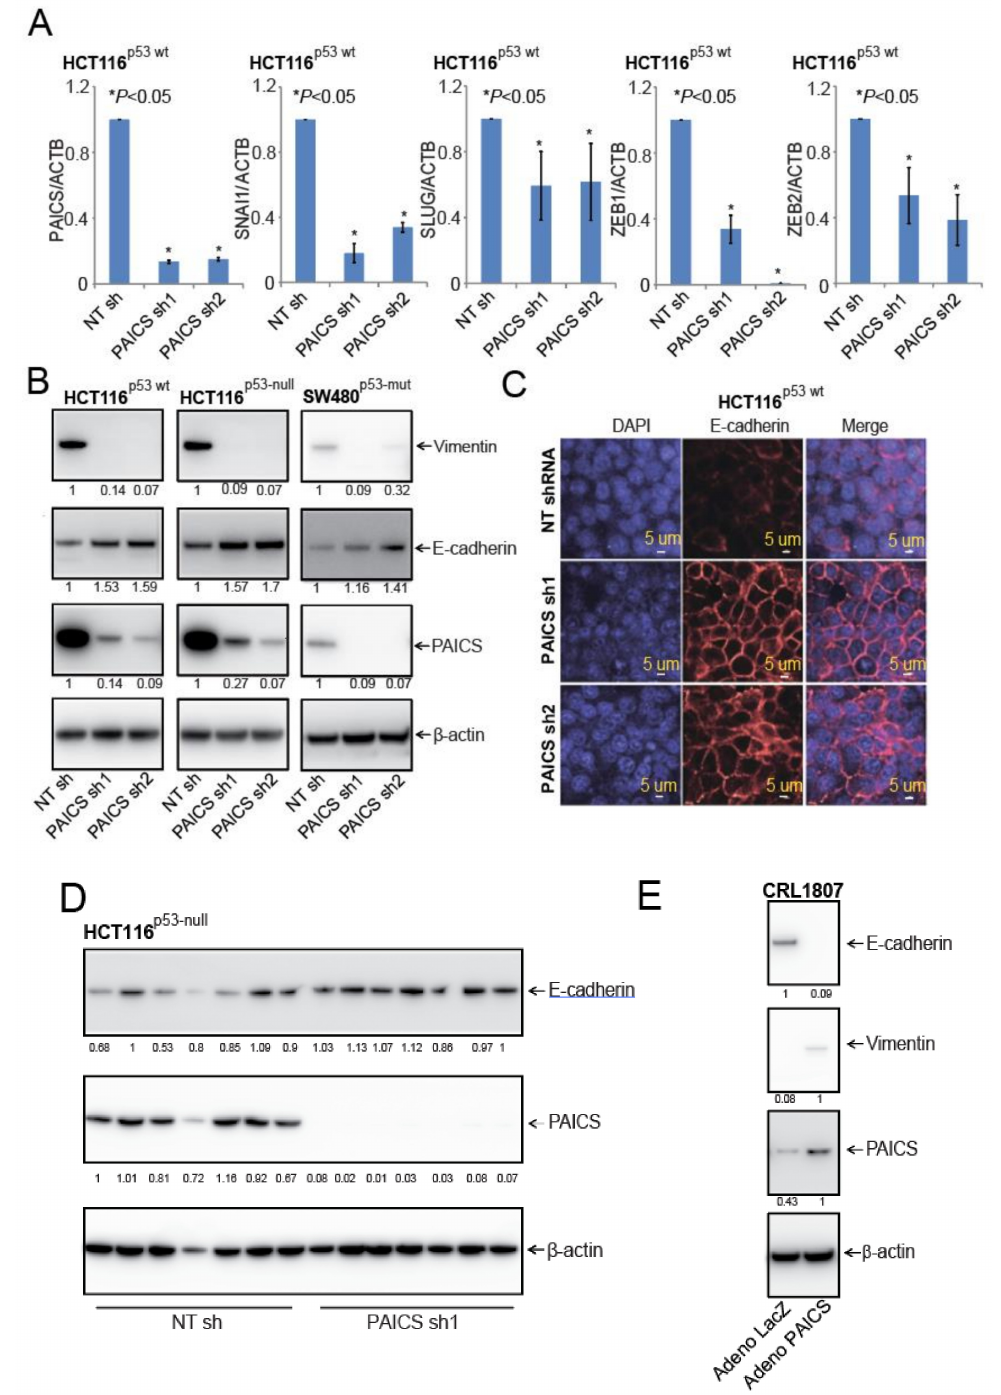
Figure 6. PAICS initiates the epithelial mesenchymal transition (EMT) in CRC. ( A ) qRT-PCR analysis